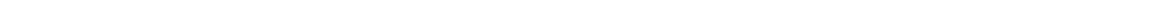
Fig. 3 LINC00173 is a granulocyte-speci fi c lincRNA. a Averaged expression ( top ) and heatmap of granulocyte fi ngerprint ncRNAs (top 30 without pseudogenes) which show increasing expression from HSCs to CMPs to GMPs. b RNA-seq of human myelopoiesis: PCA on the 1373 most variable ncRNAs in the data set. The arrow indicates the main trajectory of myeloid maturation. Bl/PM blasts/promyelocytes, MM metamyelocytes, PMN polymorphonuclear neutrophils. c SOM representation of RNA-seq data set revealing three spots of co-regulated metagenes (modules), whose expression properties are depicted in the bar charts below. d – f LINC00173 expression normalized to granulocytes as measured by d the Arraystar Human lncRNA Microarray V2.0 ( n = 3 – 5 per data point), e qRT-PCR ( n = 3), and f RNA-Seq ( n = 2 – 4). Error bars indicate ± s.e.m. g The LINC00173 gene locus depicting the array probe and alternative isoforms (according to ENSEMBL GRCh38.p5), together with UCSC genome browser tracks (http://genome.ucsc.edu ; assembly : GRCh38/hg38) of RNA-Seq and ChIP-seq data (BLUEPRINT) 24 , CAGE-Seq Signals (FANTOM5) 25 , and sequence conservation (GERP-elements) 26 in mature human neutrophils. h Guilt-by-association results for LINC00173 . Circle size corresponds to the size of the gene set, and connecting line thickness represents the degree of similarity between two gene sets. Red and blue nodes indicate positive and negative correlation to LINC00173 expression,